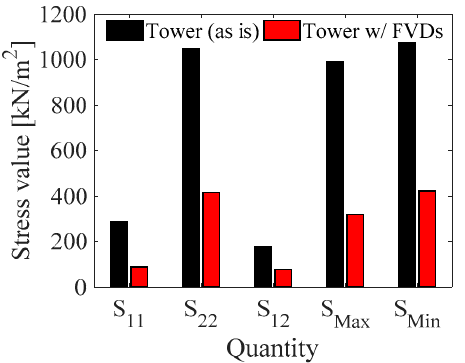
Figure 24. Masonry median stress values (single shell element at the base of the tower). Comparison before and after retrofitting.